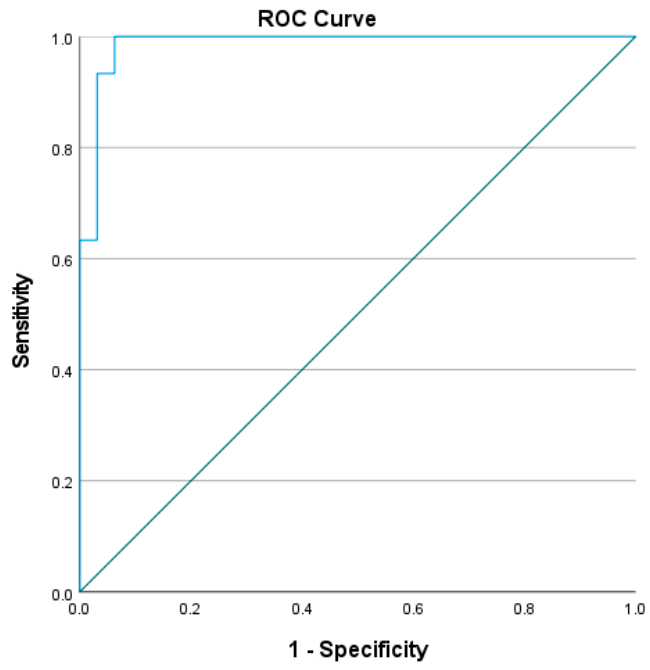
Figure 5. ROC curve of the L Test completion times involving turning towards the paretic side for the 90° and then turning towards the non-paretic side for the 180° (AUC = 98.6%, sensitivity = 100%, specificity = 93.7%, p < 0.001).